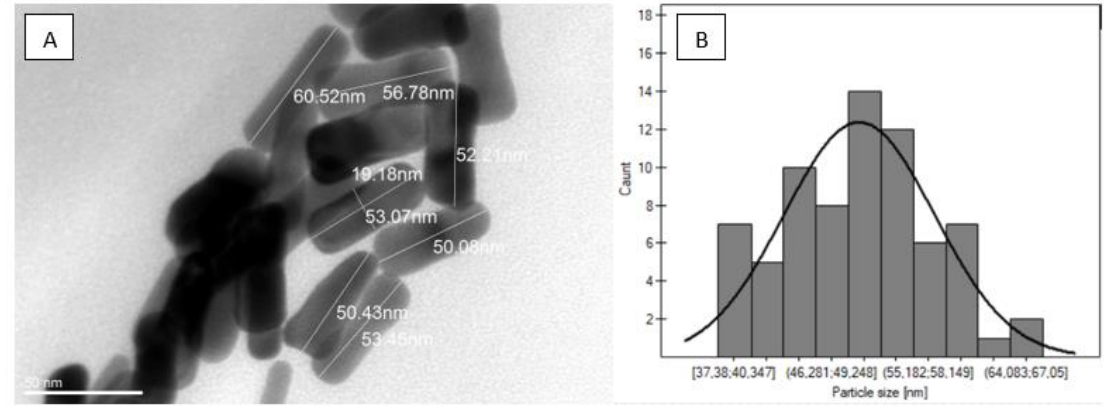
Figure 1. Nanorods morphology. ( A ): TEM images of gold nanorods used in the study. ( B ): An average size distribution of gold nanorods.